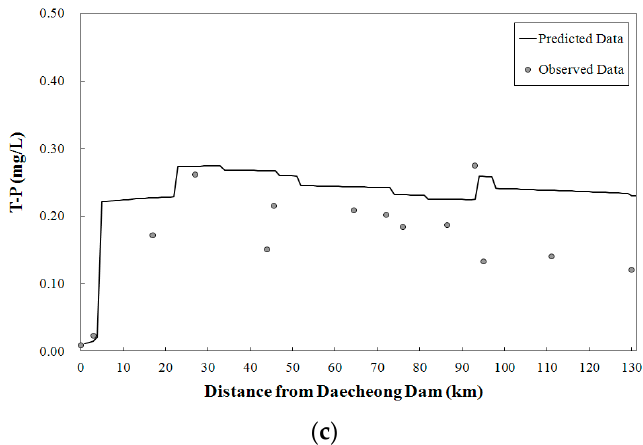
Figure 10. Calibration results of the Qual2E model (Ahn et al., 2015): ( a ) BOD according to distance; ( b ) T-N according to distance; and ( c ) T-P according to distance.